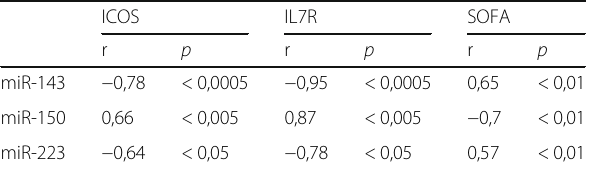
Table 8 correlation analysis miR-143, − 150, − 223